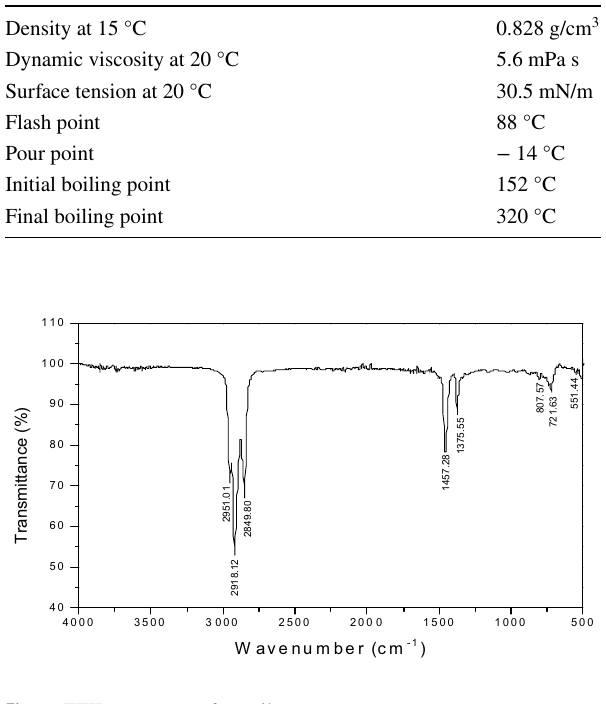
Fig. 1 FTIR spectrum of